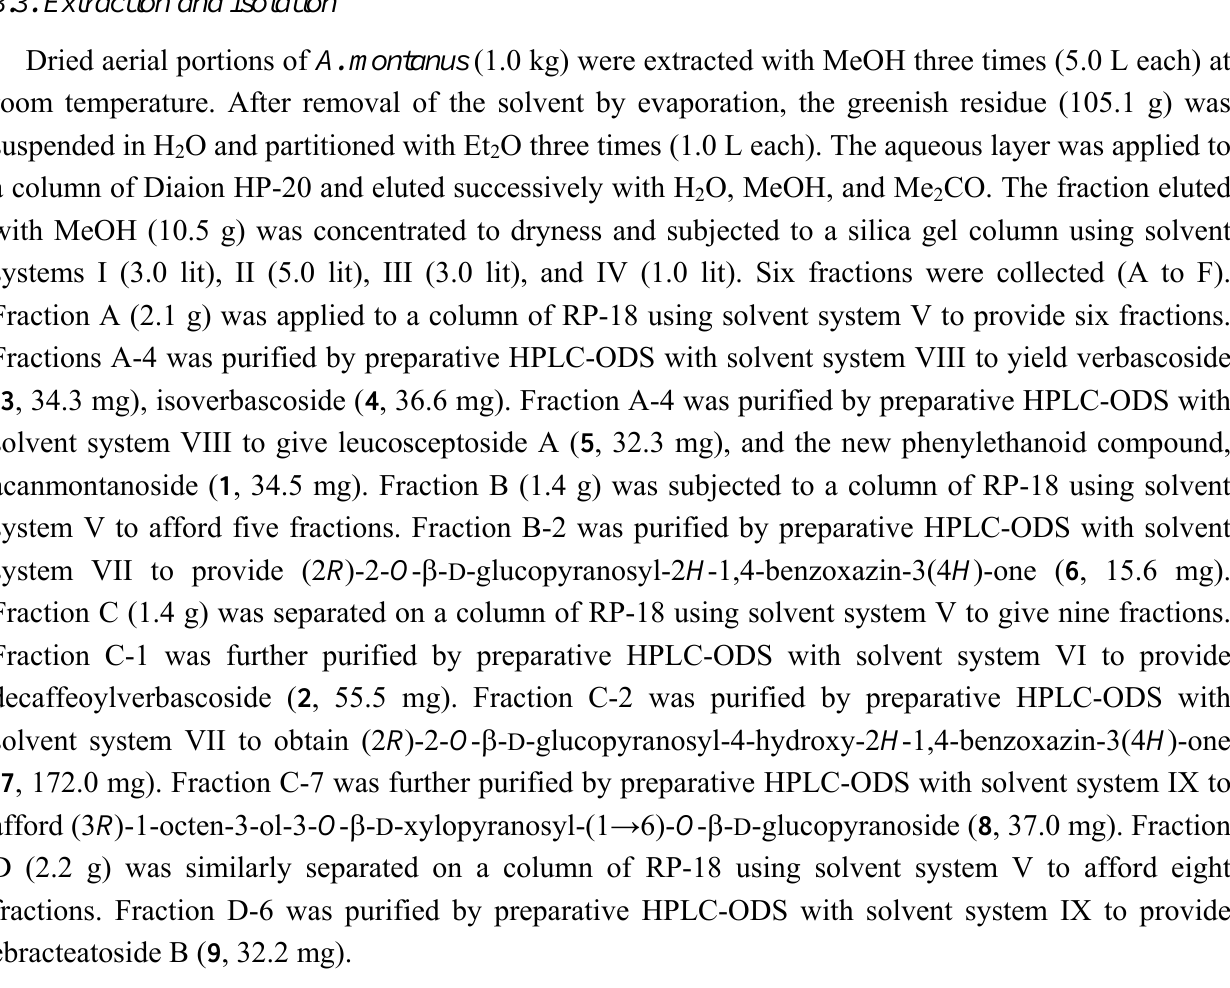
Table 1. NMR Spectroscopic data of acanmontanoside ( 1 , CD